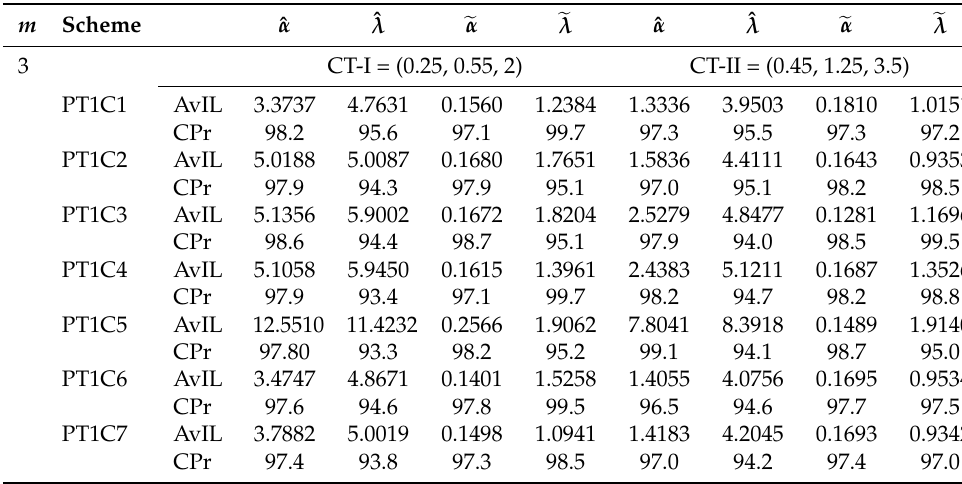
Table 6. AvILs and CPr(in %) values and MSErs of the ML and BEs for NH model with α = 0.5 and λ = 1.5 under various censoring schemes at n =